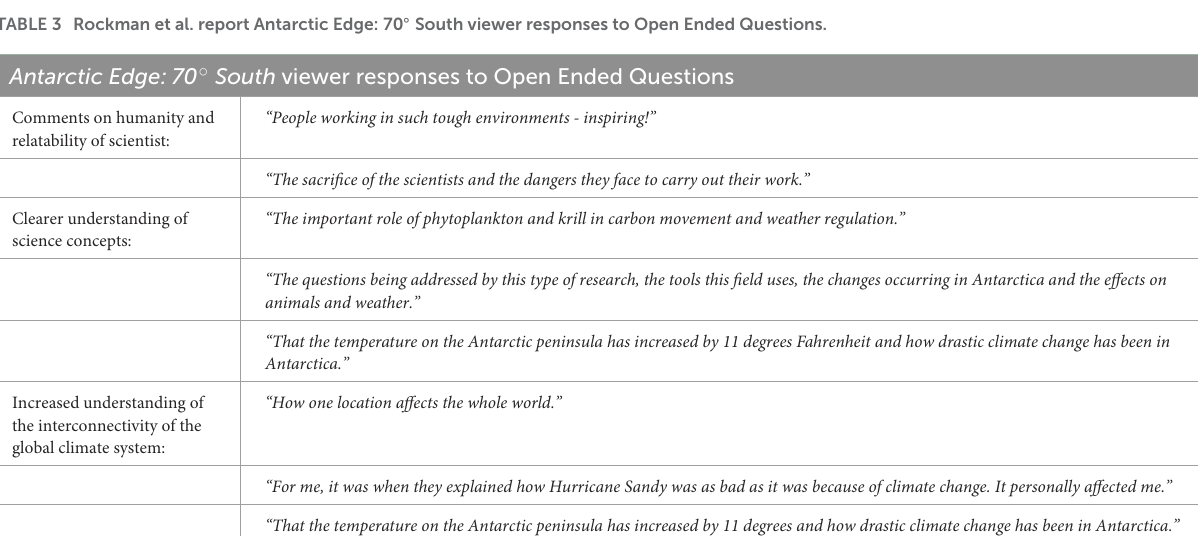
TABLE 3 Rockman et al. report Antarctic Edge: 70 ◦ South viewer responses to Open Ended